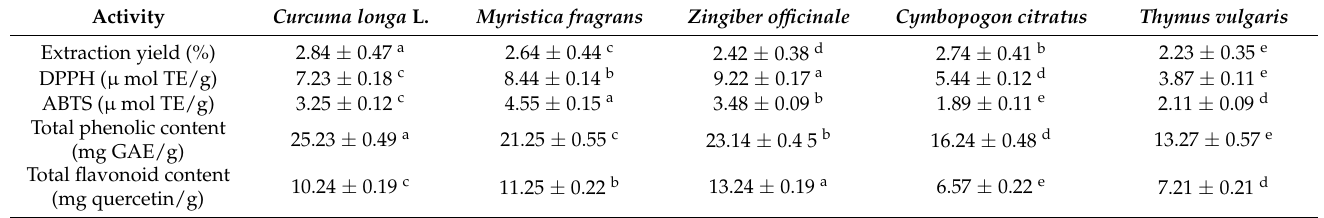
Table 1. Extraction yield, phenolic, flavonoids content, and antioxidant activities of some aqueous plant